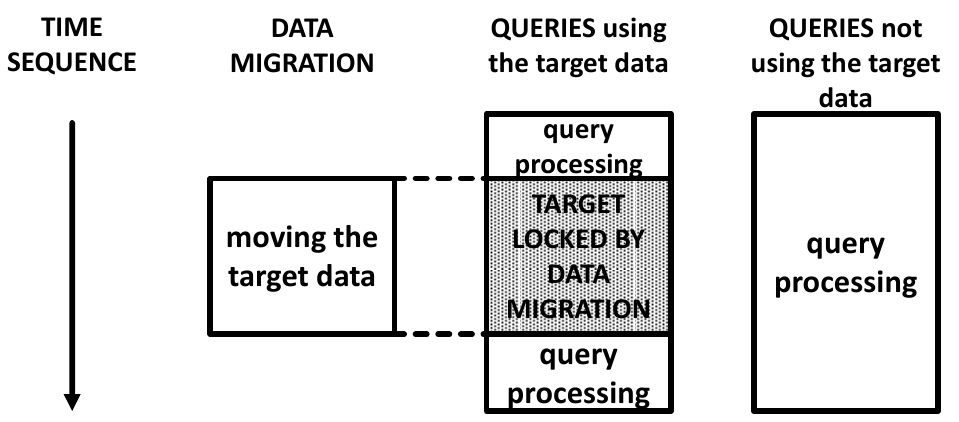
Fig. 2. a data migration operation and other operations in the data migration scheme without making snapshot . Published by Atlantis